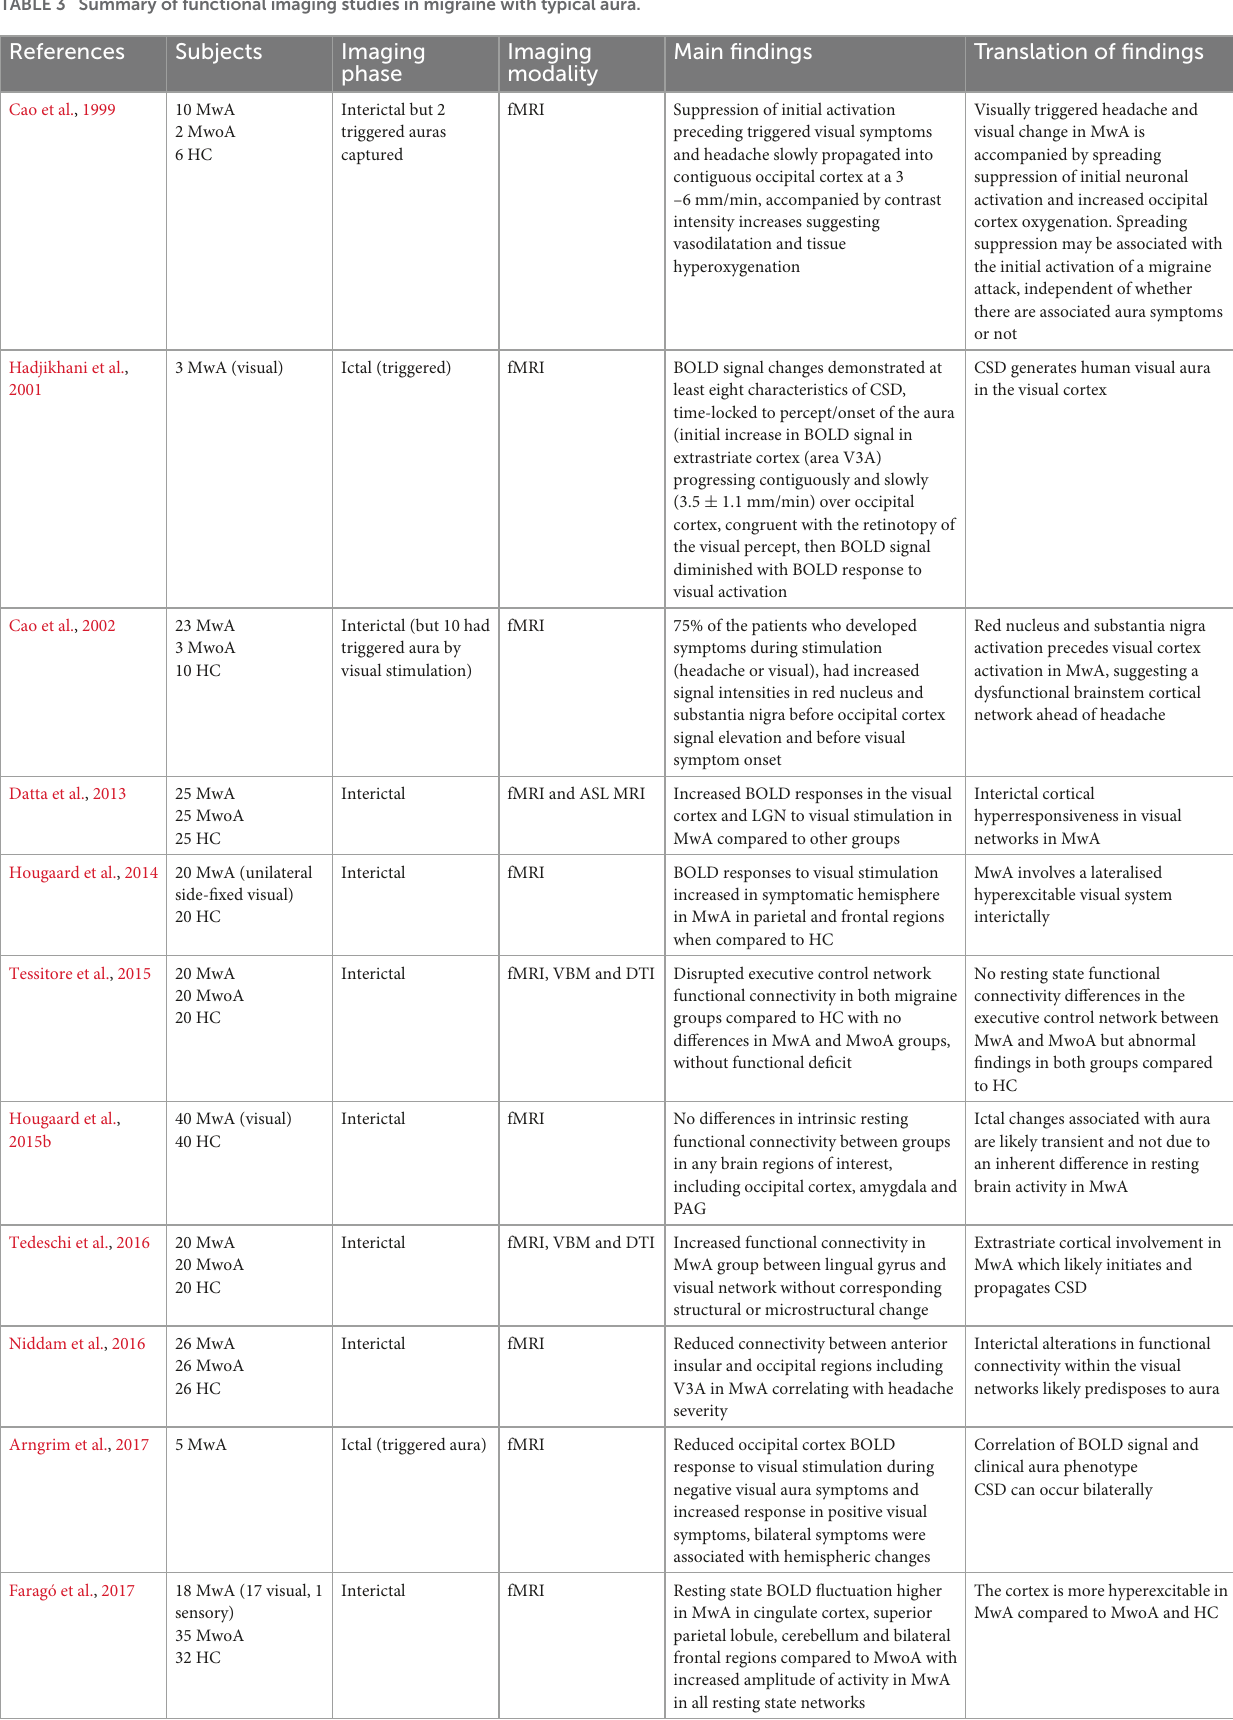
TABLE 3 Summary of functional imaging studies in migraine with typical